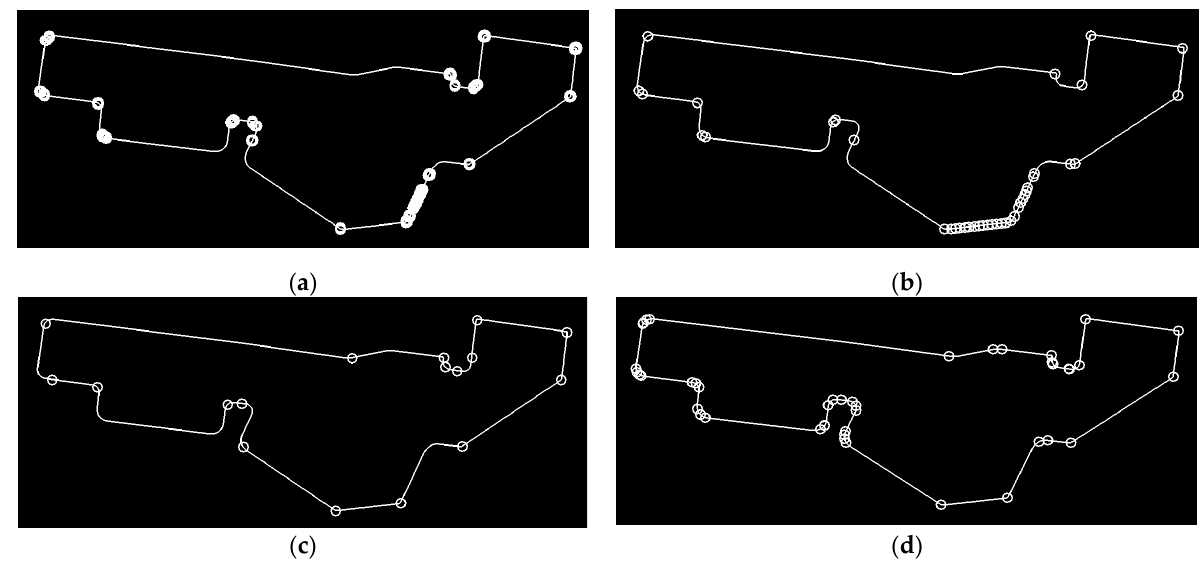
Figure 19. Comparison of the results of multiple corner point detection algorithms: ( a ) Harris corner detection, ( b ) Shi-Tomasi corner detection, ( c ) CSS corner extraction operator, and ( d ) the corner point detection algorithm proposed in this paper.